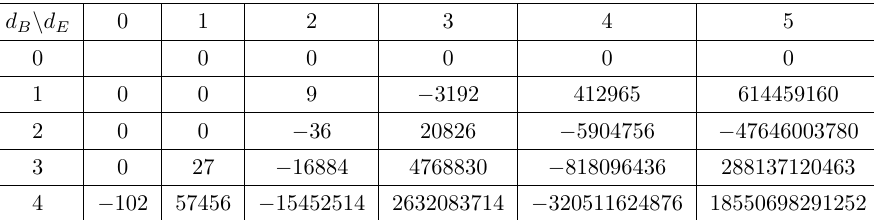
for the genus ( g ) = (2 , 0) . L , g R ( d B ,d E )